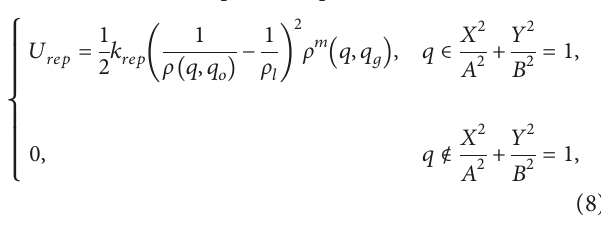
Figure 10: Decomposition repulsion